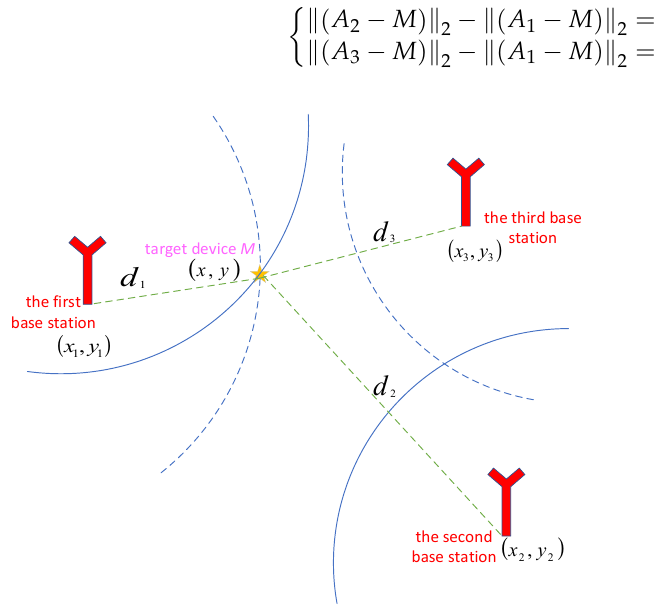
Figure 5. TDOA hyperbolic model.